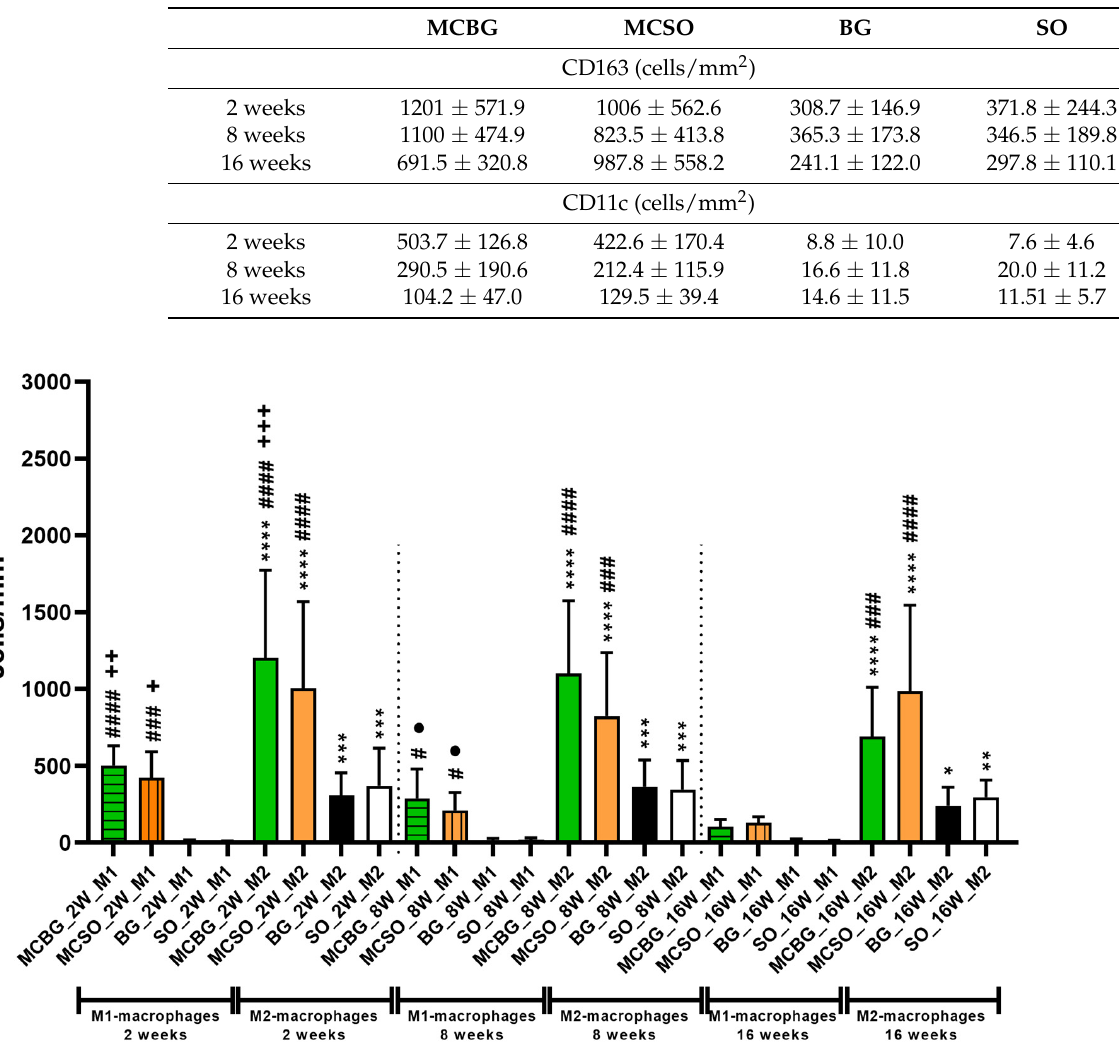
Table 2. Macrophage subtype numbers at 2, 8, and 16 weeks post implantationem. MCBG: membrane compartment above bone graft-filled defects; MCSO: membrane compartment above sham operation; BG: bone graft-filled defects; and SO: sham operation bone defect.